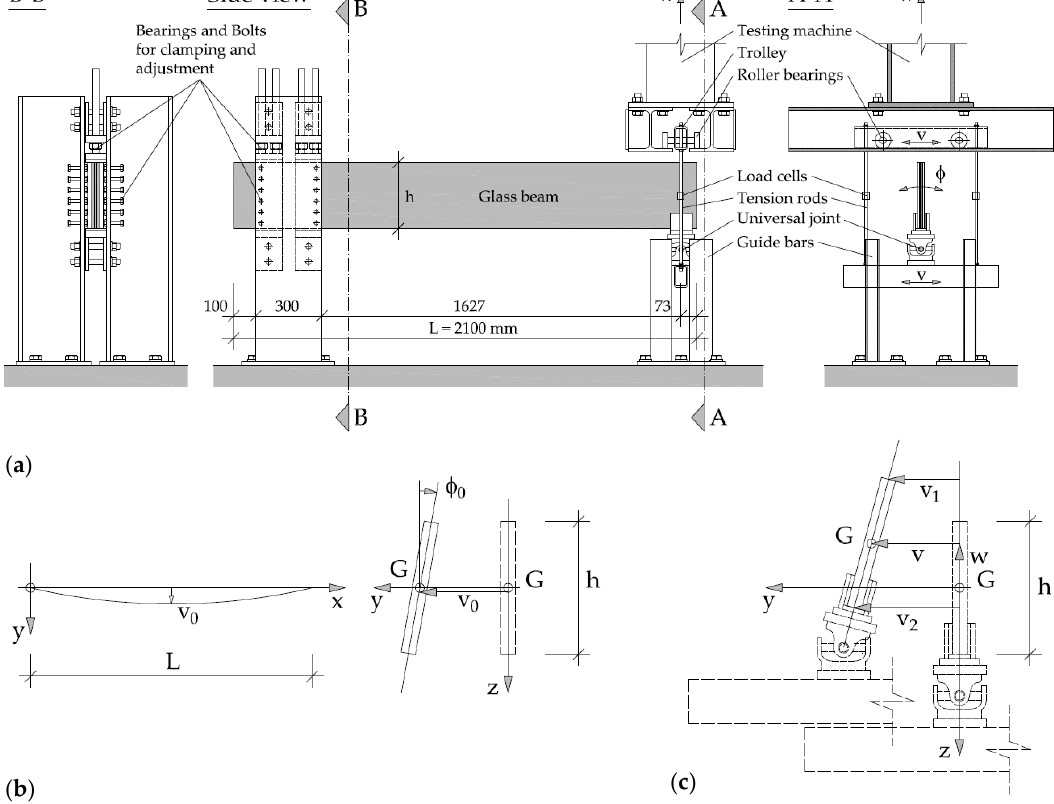
Figure 1. ( a ) Testing device, ( b ) coordinate system and definition of the imperfections, ( c ) definition of the measured displacements at the free end of the cantilever beam.